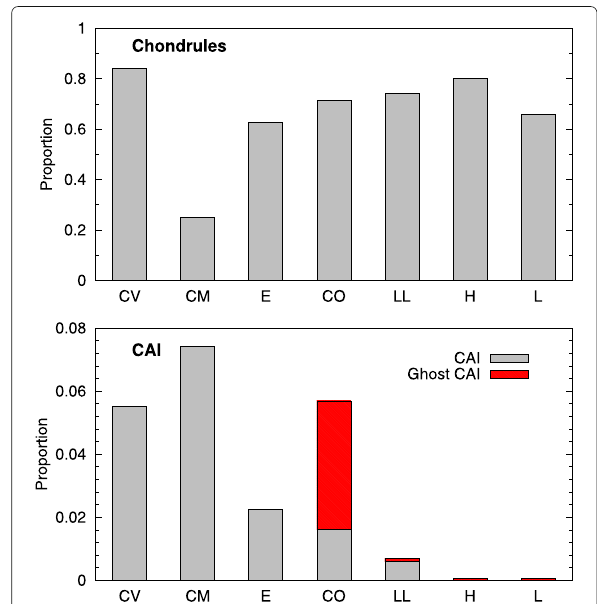
Fig. 8 Molar proportion of chondrules (top panel), and CAIs + ghost CAIs (bottom panel) in the bulk chondrite